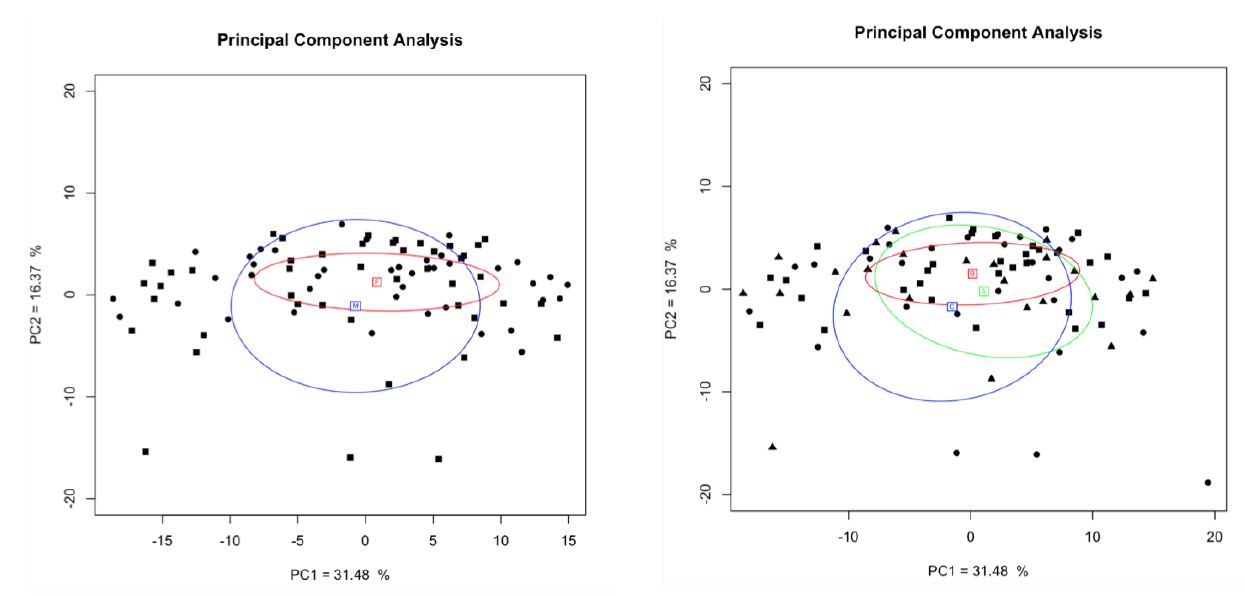
Figure 4. Principal-component analysis on the shape of the inferior turbinate based on a) gender (females=red, males=blue) and b) age (patient’s age < 30 y=blue, patient’s age between 30 and 60 y=red, patient’s age > 60 y= green). The ellipses correspond to 68% confidence